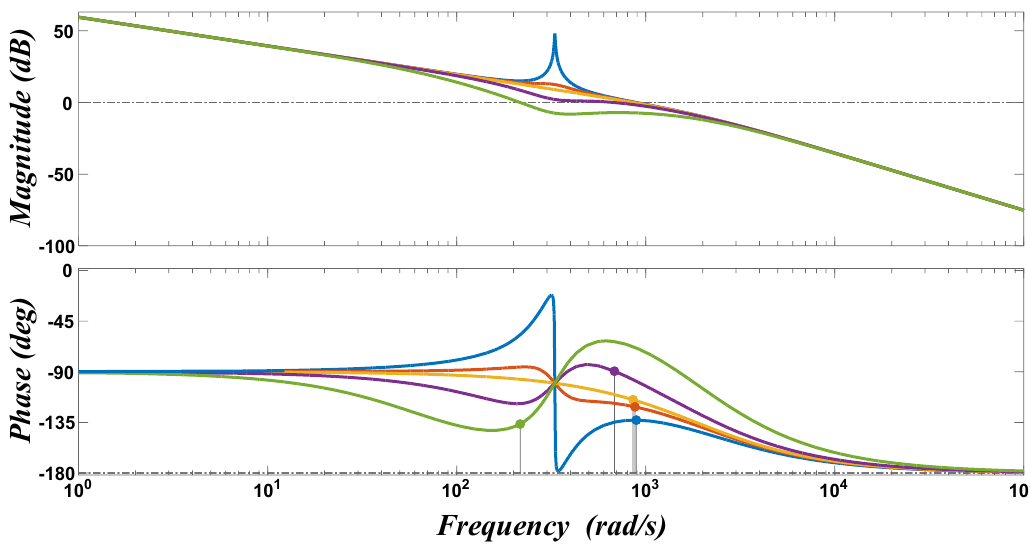
Figure 13. Bode plots for five different operating